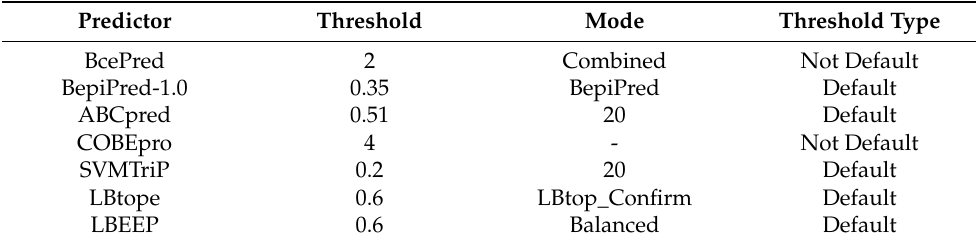
Table 2. A summary of methods, threshold values, and modifications applied to each predictor. Each predictor first had its best performing mode selected and its threshold value set to a specific value shown in the table, using the criteria described in the manuscript.